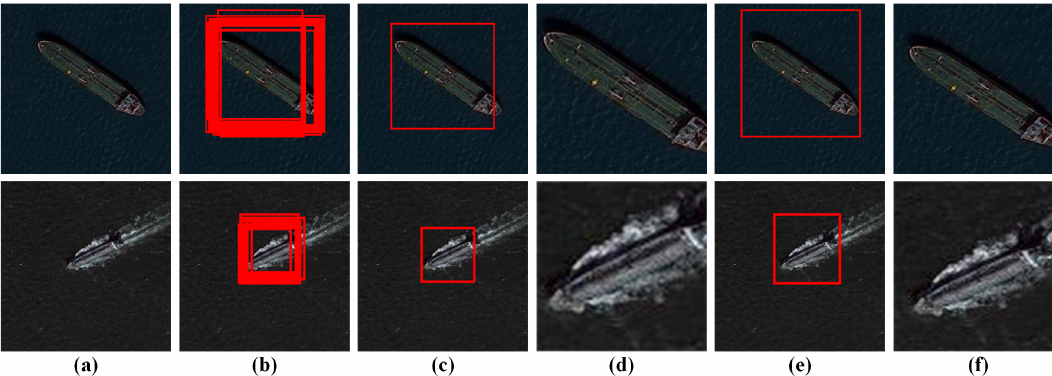
Figure 4. The results of different Non-Maximum Suppression (NMS) methods. ( a ) The small slice of input image. ( b ) The detection result of the network with many overlapping boxes. ( c ) The detection result of traditional NMS. ( d ) The target patch extracted by traditional NMS. ( e ) The detection result of Bigger-Left Non-Maximum Suppression (BL-NMS). ( f ) The target patch extracted by